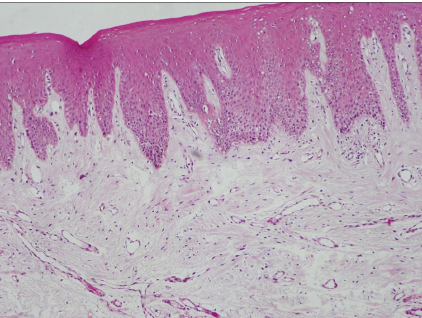
Figure 1: Photomicrograph of the section shows normal buccal mucosa (H&E 10x).